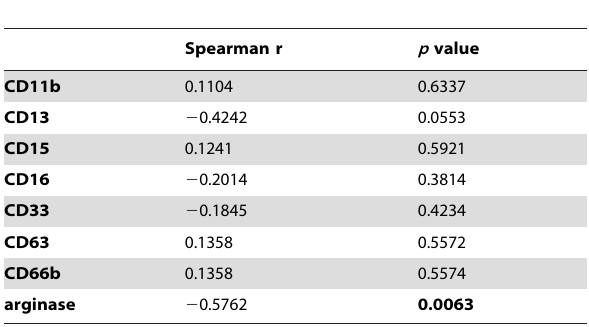
Table 7. Correlation between viral loads and MFIs.